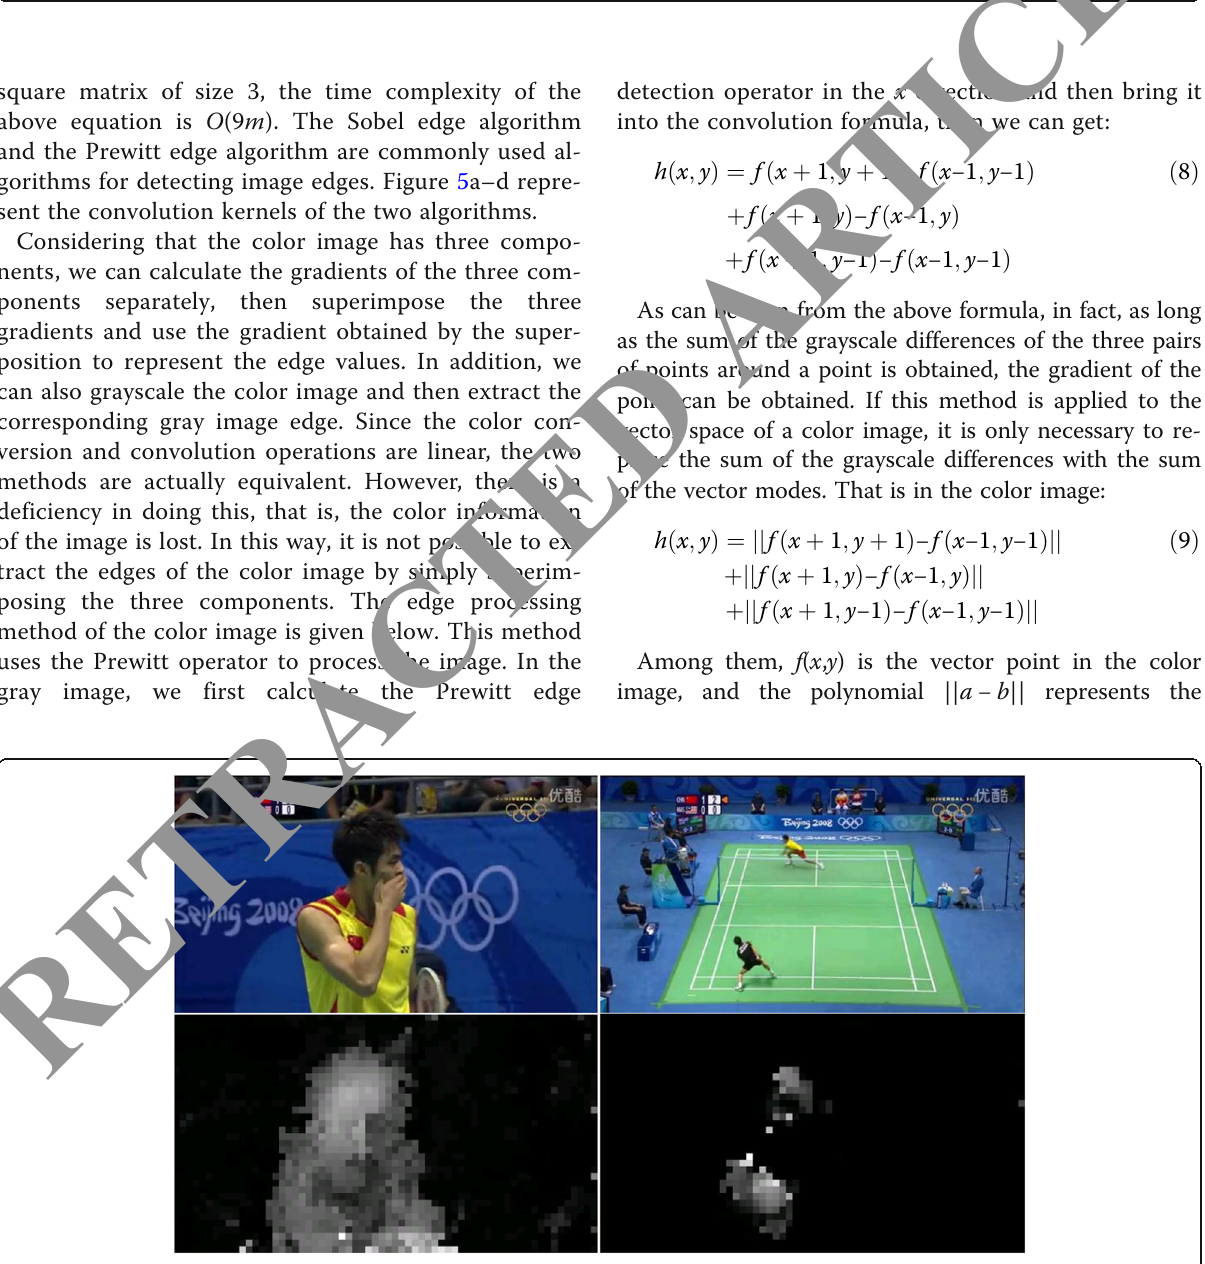
Fig. 4 The salient region of the dynamic